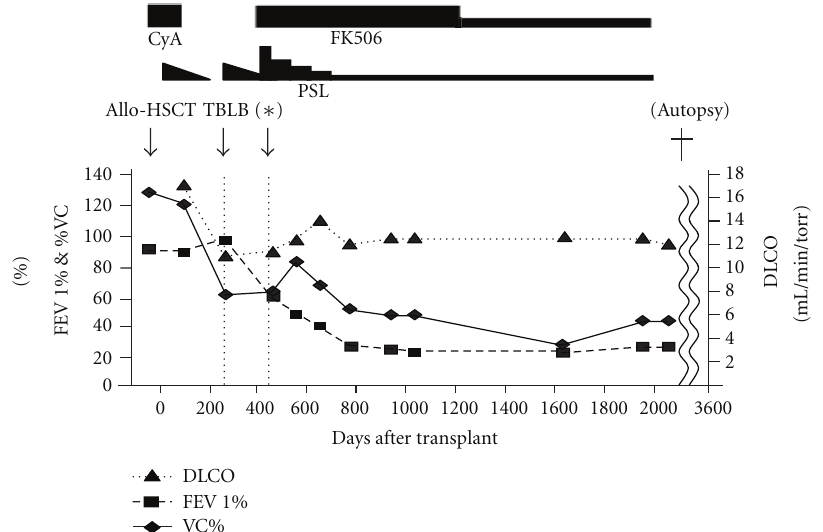
Figure 1: Clinical course and the results of PFT. The solid line and the dotted lines show DLCO, FEV1.0%, and %VC. ( ∗ ) The time point that diagnosis of BO was made according to the result of PFT. CyA, cyclosporine A; FK506, tacrolimus; Allo-HSCT, allogeneic hematopoietic stem cell transplantation; TBLB, transbronchial lung biopsy; PSL, predonisolone; DLCO, di ff using capacity for carbon monoxide; FEV1.0%, forced expiratory volume 1.0(sec) %; %VC, % vital